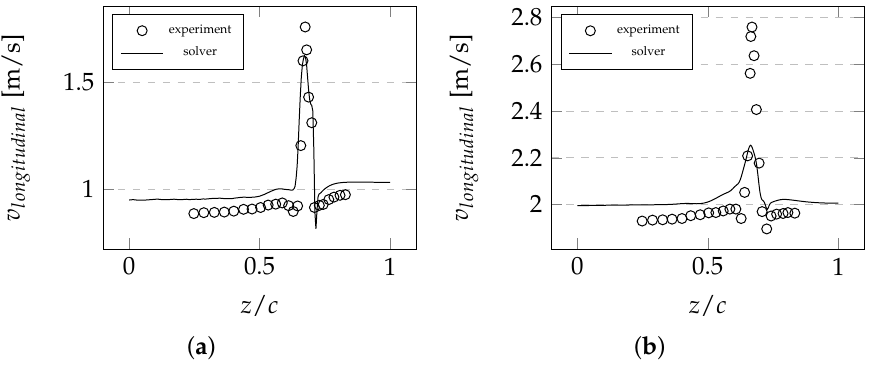
Figure 23. Longitudinal velocity along the span-wise direction at ( a ) x / c = 0 and ( b ) x / c = 0.24.